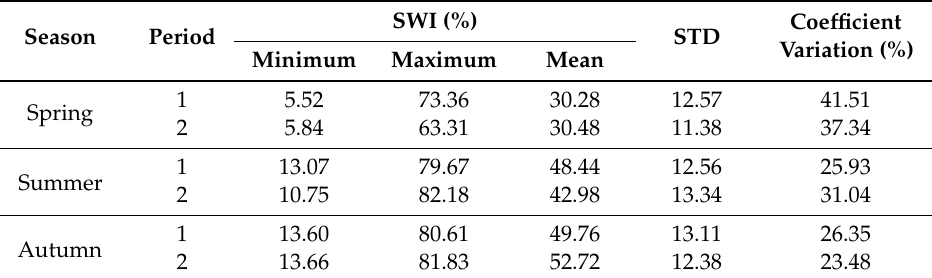
Table 3. Statistical characteristics of seasonal SWI on the Loess Plateau.